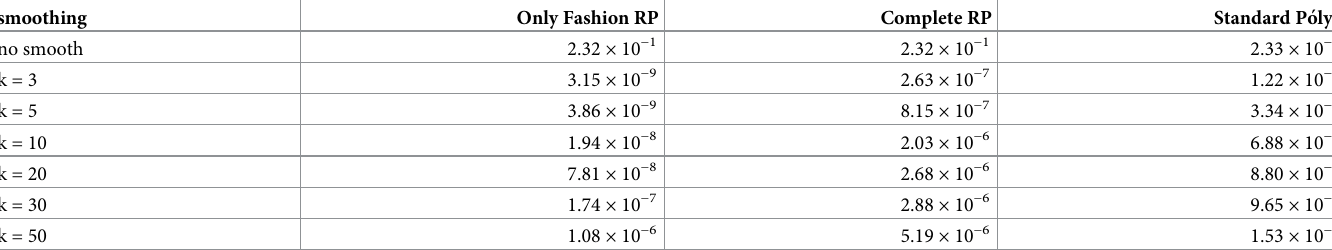
Table 20. “10 days of traffic” ( T = 0.35, entire, D = 30 00 , slots = days): MSE for different levels of smoothing.